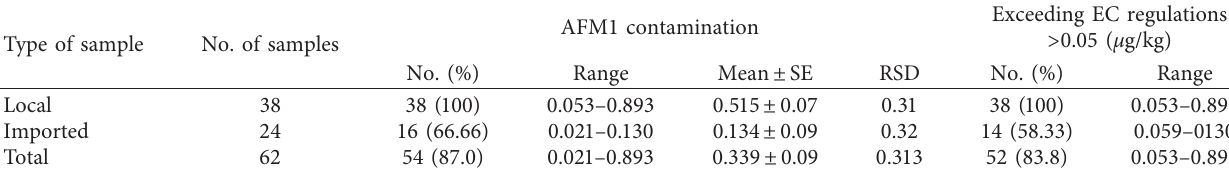
Table 4: AFM1 in yogurt samples through HPLC.